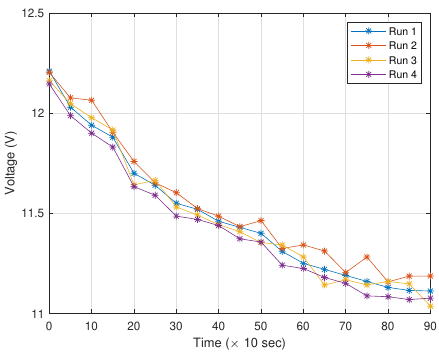
Figure 3. Illustration on variations of the remaining voltage from the power supply under various